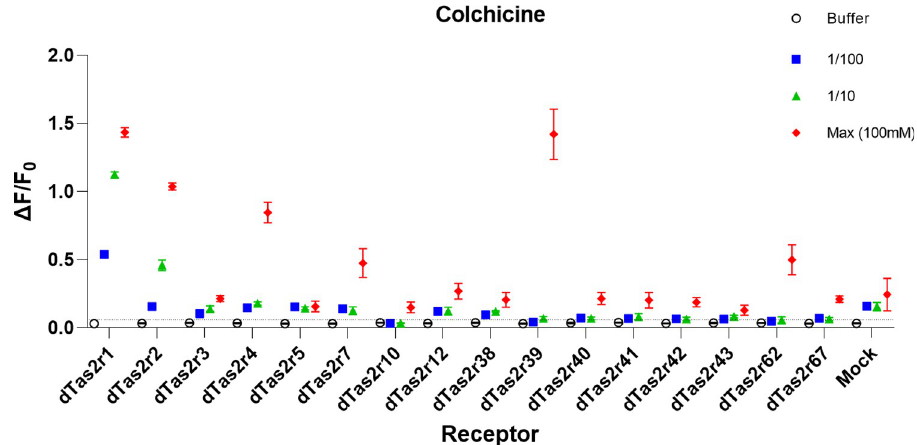
Fig 1. Calcium responses of transfected HEK293T/G α 16i/o44 cells screened with three concentrations of Colchicine. The receptors dTas2r1, 2, 3, 4, 5, 7, 38, and 39 were selected for testing in a full concentration-response experiment. Dog Tas2rs are on the x-axis, the y-axis shows the maximum change in fluorescence divided by the baseline fluorescence before compound injection ( Δ F/F 0 ).